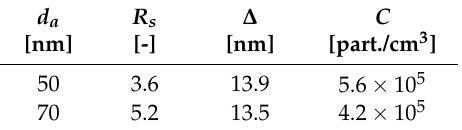
Table 1. Overview of the AAC parameter R s for different aerodynamic